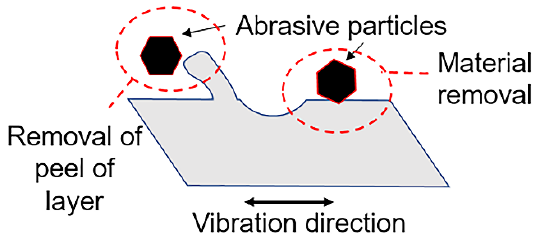
Figure 9. Removal of the peel-off layer via abrasive polishing.